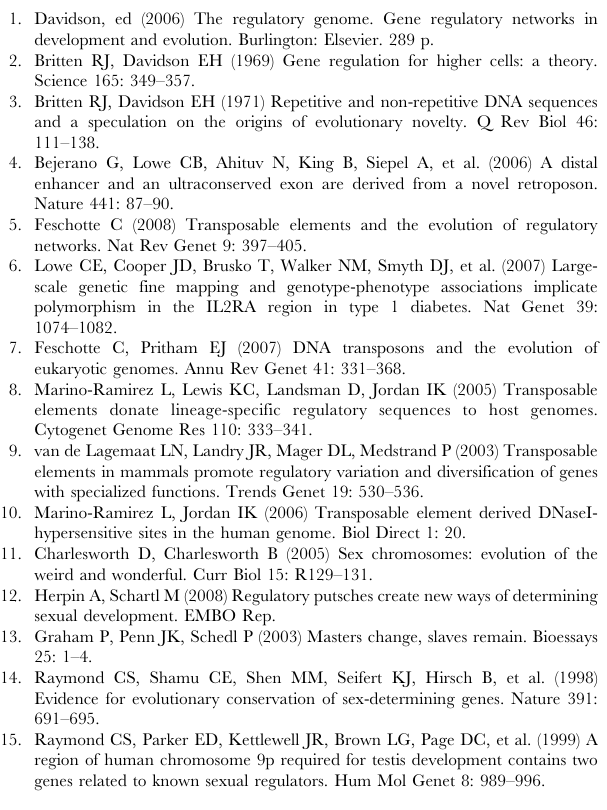
Figure S6 Timing of repeat insertions into the dmrt1bY promoter. Linearized NJ trees for dmrt1 (A) and tyra (B) genes based on third codon positions using the Kimura-2-parameter model are shown. The split between fugu and Oryzias species was set to 95 million years ago (MYA) [41]. The sequence divergence between repeats 1 and 2 and their consensus sequence, respectively, is indicated. The repeat 1 origin falls onto the branch, at which the dmrt1 gene duplication has occurred [41] and is younger than the inferred dmrt1 duplication period (blue). The repeat 2 insertion is very recent. Other models of sequence evolution gave similar results. Figure S7 Transient transfection analysis of the Dmrt1bY promoter nested Dmrt1 binding site. Transcriptional activity of the mutant 3 Kb proximal Dmrt1bY promoter (mutated Dmrt1 binding site) was not significantly impaired while overexpressing dmrt1bY or not. Found at: doi:10.1371/journal.pgen.1000844.s007 (1.78 MB PDF) Table S1 Location and adjacent genes of repeat 1 elements containing Dmrt1 binding sites in the medaka